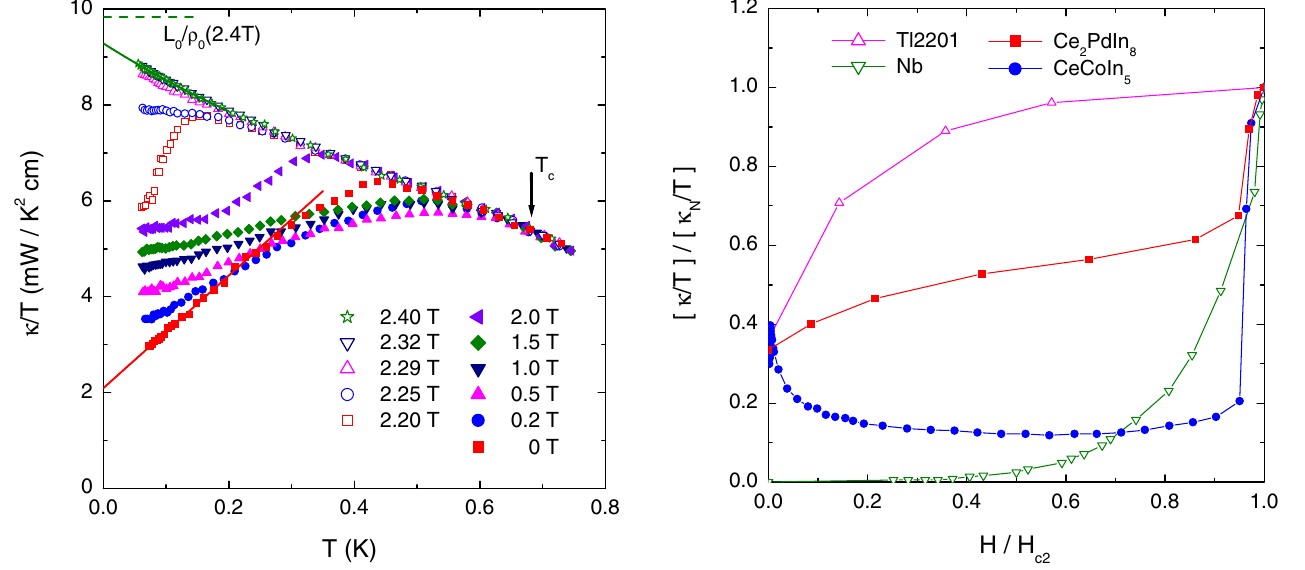
FIG. 3. Low-temperature in-plane thermal conductivity of FIG. 4. Normalized (cid:2)=T to the normal-state value for PdIn c axis. The Ce PdIn CeCoIn Ce 2 8 in magnetic fields applied along the 2 8 at 60 mK, and for 5 at 50 mK [33], as a saturation of (cid:2)=T toward 2 : 32 T confirms it as the bulk H c 2 . function of H=H c 2 . For both compounds, the sharp jump of (cid:2)=T near H The solid lines are fits to the H ¼ 0 and 2 : 4 T data (see text). The c 2 indicates a first-order phase transition. Similar data dashed line at the top left of the panel is the normal-state of the clean s -wave superconductor Nb [37] and an overdoped d -wave superconductor Tl-2201 [38] at T ! 0 are also shown Wiedemann-Franz law expectation L 0 =(cid:1) 0 ð 2 : 4T Þ , with L 0 ¼ ð 2 : 4T Þ ¼ 2 : 49 (cid:3) (cid:1)cm . 2 : 45 (cid:5) 10 (cid:2) 8 W(cid:1)K (cid:2) 2 and (cid:1) for 0